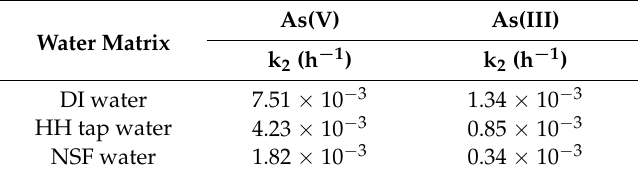
Table 6. Second-order rate constant (k 2 ) for the three examined different water matrixes.